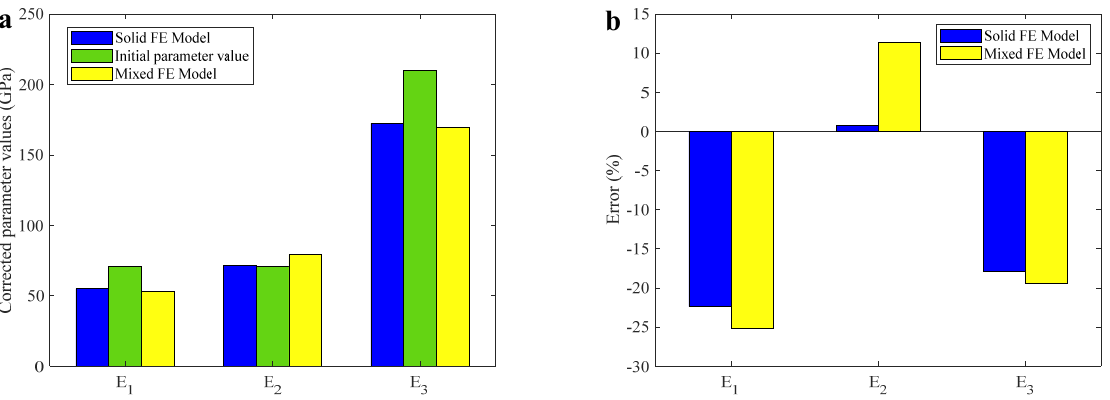
Figure 10. Parameter changes before and after correction. ( a ) Parameter values before and after correction. ( b ) Parameter change rate before and after correction.